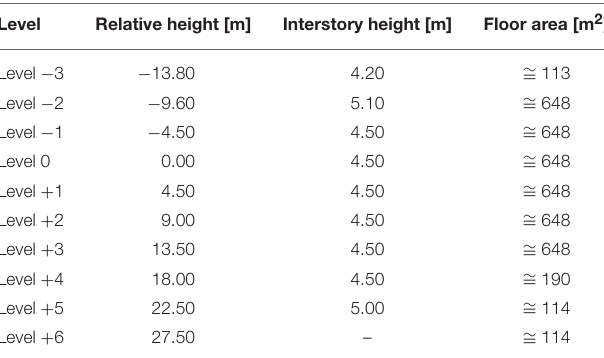
TABLE 1 | Floor surfaces, plan and interstory heights of the “Archivio di Stato”